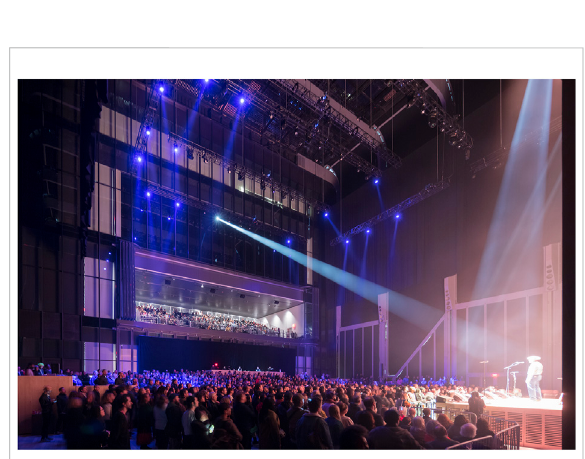
FIGURE 5 Interior View of the McCourt Hall; Photography: Iwan Baan, reprinted with permission of The Shed/Diller Sco fi dio +